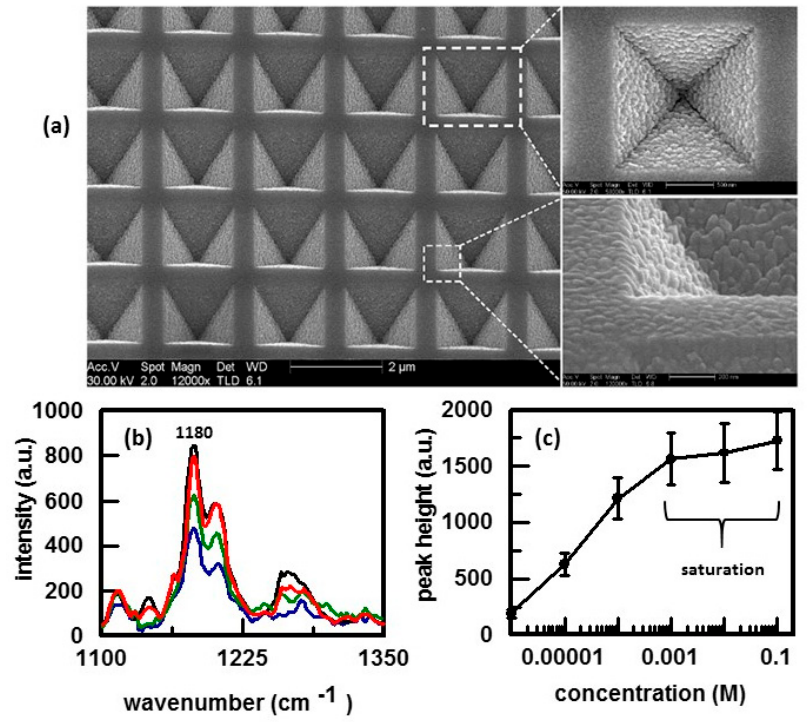
Figure 11. ( a ) Electron micrographs of the pyramidal wells in Klarite showing the roughened gold structure. Reproduced with permission from the Royal Society of Chemistry, 2010 [121]; ( b ) SERS spectra of ibuprofen as a function of concentration and ( c ) Plot of 1180 cm − 1 peak height as a function of ibuprofen concentration. Reproduced with permission from Samedan Ltd, 2010 [122].